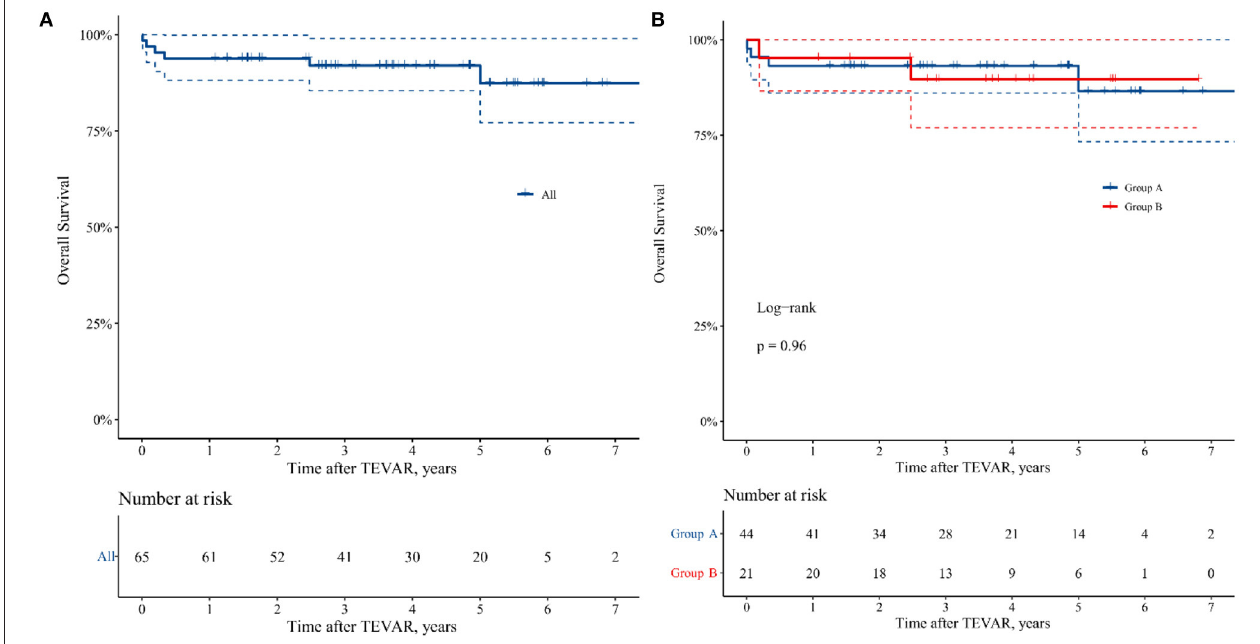
FIGURE 3 | Kaplan–Meier curve of 7 years freedom from all causes mortality in the patients undergoing TEVAR. (A) All the patients. (B) Group A: patients with TAIMH and entry tear in descending aorta, and Group B: patients with TAIMH and penetrating atherosclerotic ulcer (PAU) in descending